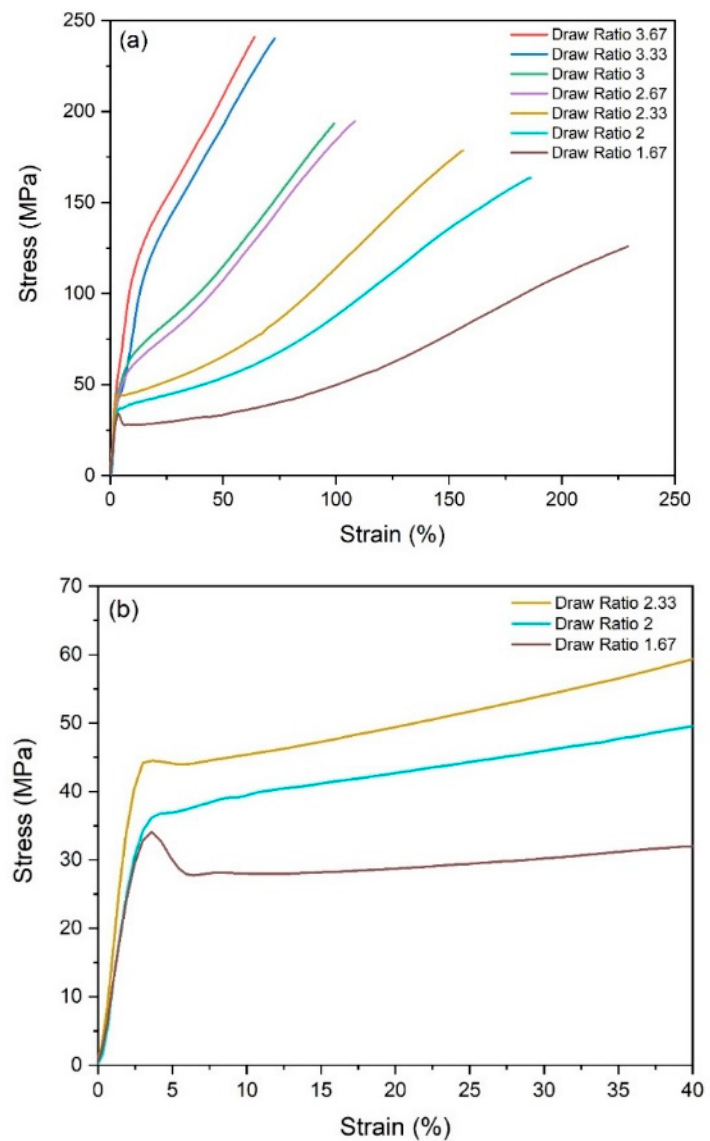
Figure 4. Tensile curves for the PBT bicomponent fibers. ( a ) shows all representative curves with different DR, while ( b ) shows zoomed in section (strain 0–40) of DR = 1.67, 2.0, and 2.33.